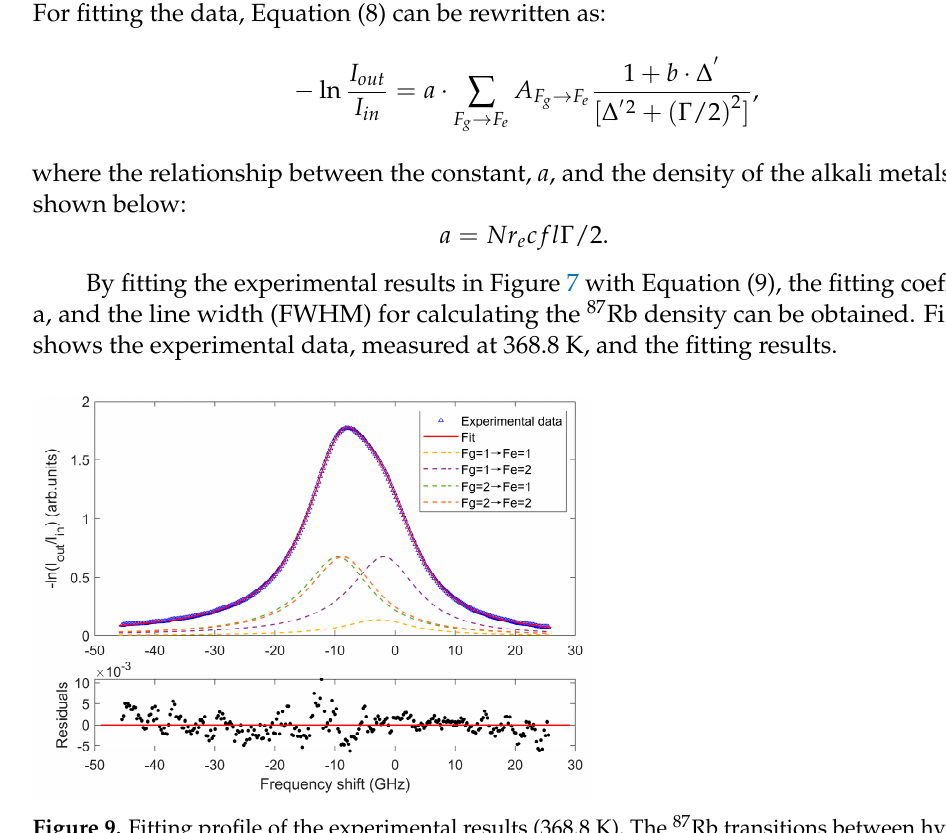
Figure 8. Experimental results of absorption spectrum for 87Rb D1 line broadened by N2 at different temperatures.